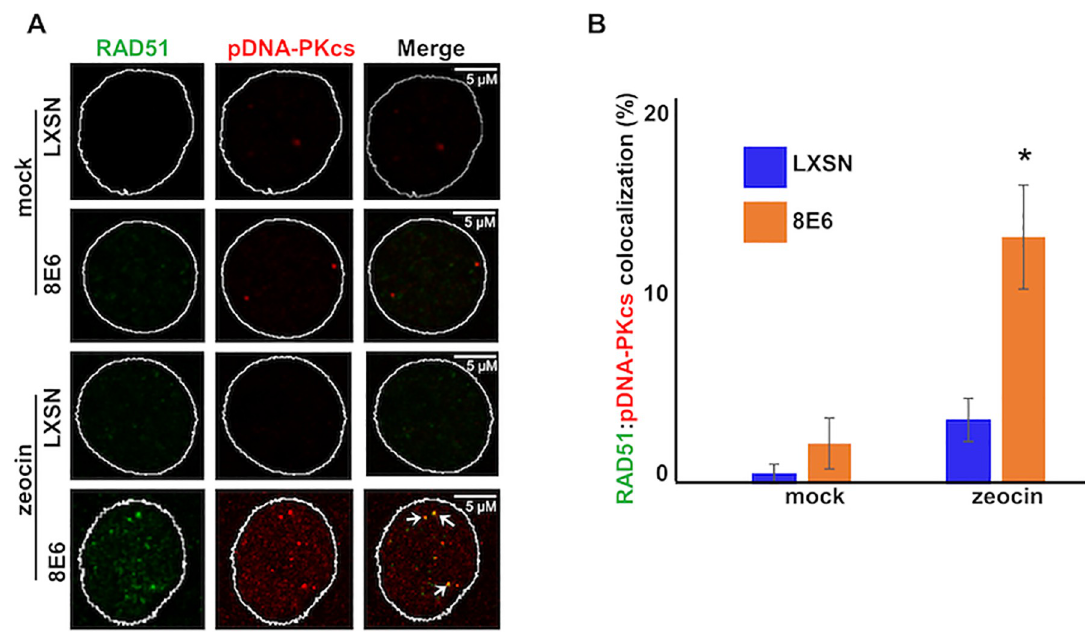
Fig 1. 8E6 allows RAD51:pDNA-PKcs colocalization. (A) Representative images of HFK LXSN and HFK 8E6 cells stained for RAD51 (green) and pDNA-PKcs (red) 24 hours after DSB induction by growth in media containing zeocin (10 μ g/mL, 10 min) or media containing additional water (solvent for zeocin) as a negative control. Additional water control is described as “mock” in Figure. White arrows indicate colocalizing RAD51 and pDNA-PKcs foci. (B) Percentage of HFK cells with colocalized RAD51 and pDNA-PKcs foci after mock treatment or zeocin treatment. All values are represented as mean ± standard error. The statistical significance of differences between cell lines were determined using Student’s t-test. � indicates significant difference between 8E6 and LXSN with same treatment (p < 0.05). At least 150 cells were counted over three independent experiments. Nuclei were determined by DAPI staining. The edge of this staining is shown by a white line depicting the